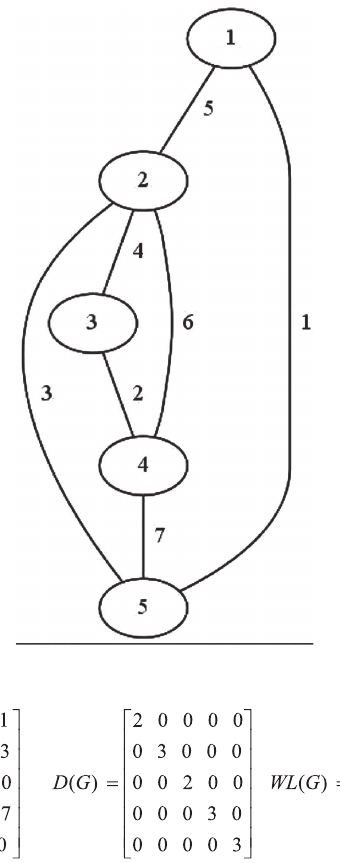
Figure 2: Weighted Graph G (5, 7) (Order | V | = 5 and Size | E | = 7, Labelled Arbitrarily) and Its Associated Weighted Adjacency Matrix WA ( G ), Degree Matrix D ( G ) and Weighted Laplacian Matrix WL ( G ), Respectively ( WL ( G ) = D ( G ) − WA ( G )).